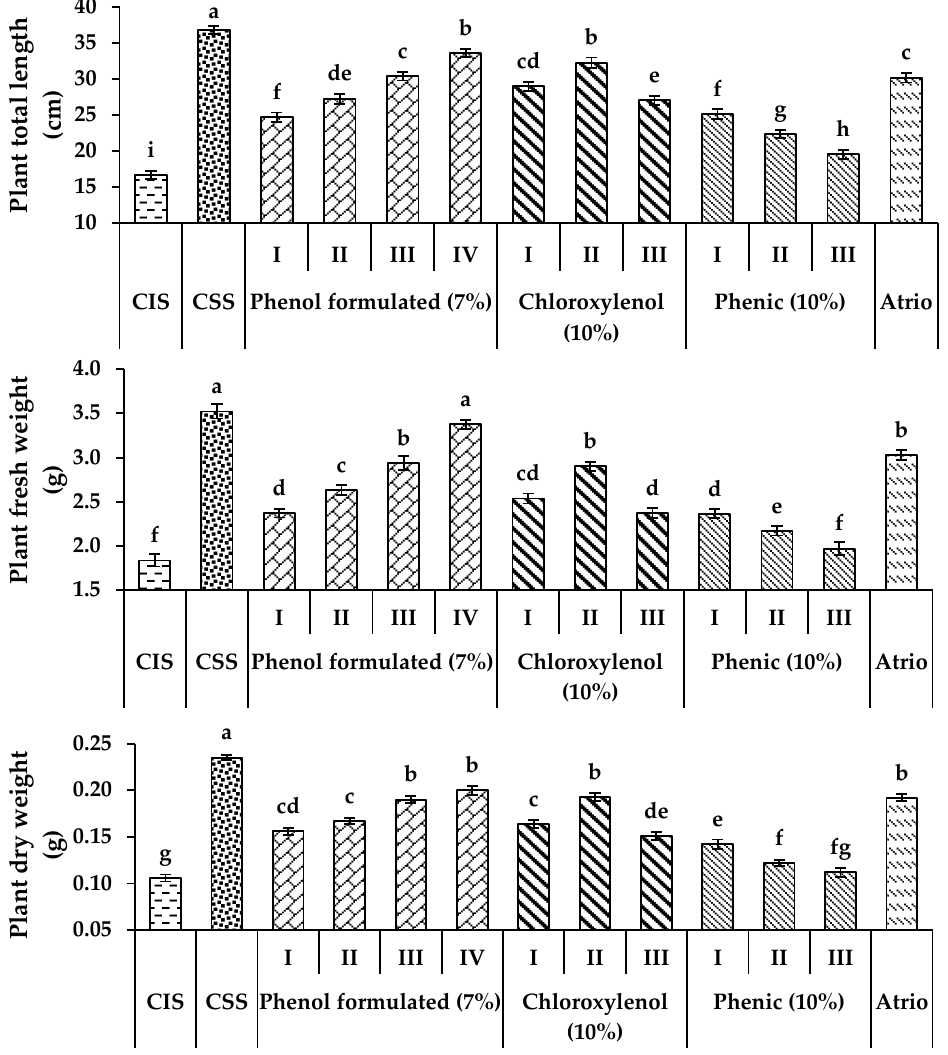
Figure 3. Effect of disinfectant agents at different concentrations and atrio 80% on growth parameters of tomato seedlings infected by S. rolfsii at 35 DAP. CIS; Control infected soil; CSS; control sterilized soil; (I) 125 µ L 100 mL − 1 ; (II) 250 µ L 100 mL − 1 ; (III) 500 µ L 100 mL − 1 ; (IV) 1000 µ L 100 mL − 1 . The values shown in the figures are means ± SEM ( n = 3), with different alphabetic letter/s being significantly different ( p < 0.05) following Tukey’s post hoc test.